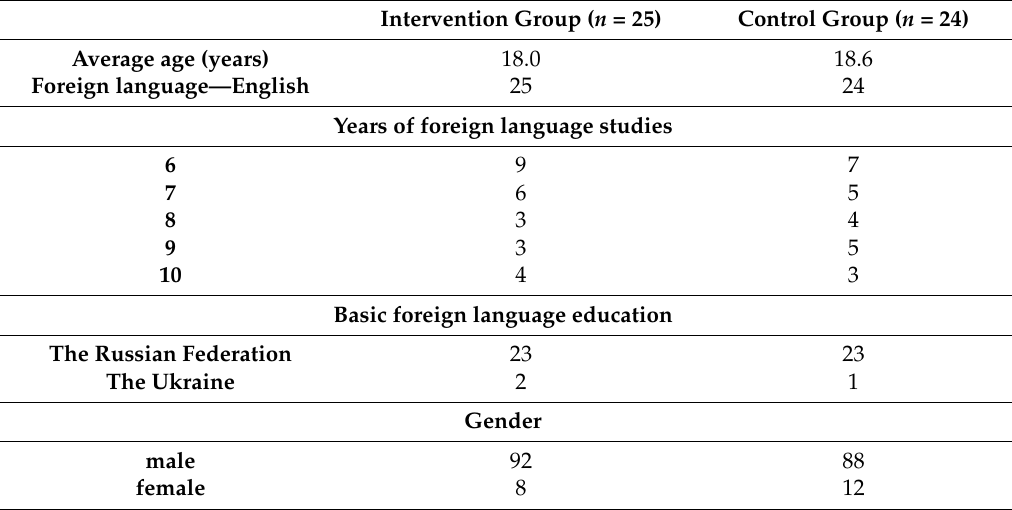
Table 1. Descriptive statistics of the Intervention and Control